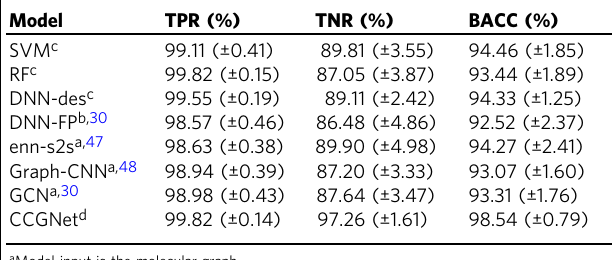
Table 3 Performances of the models on the tenfold cross-